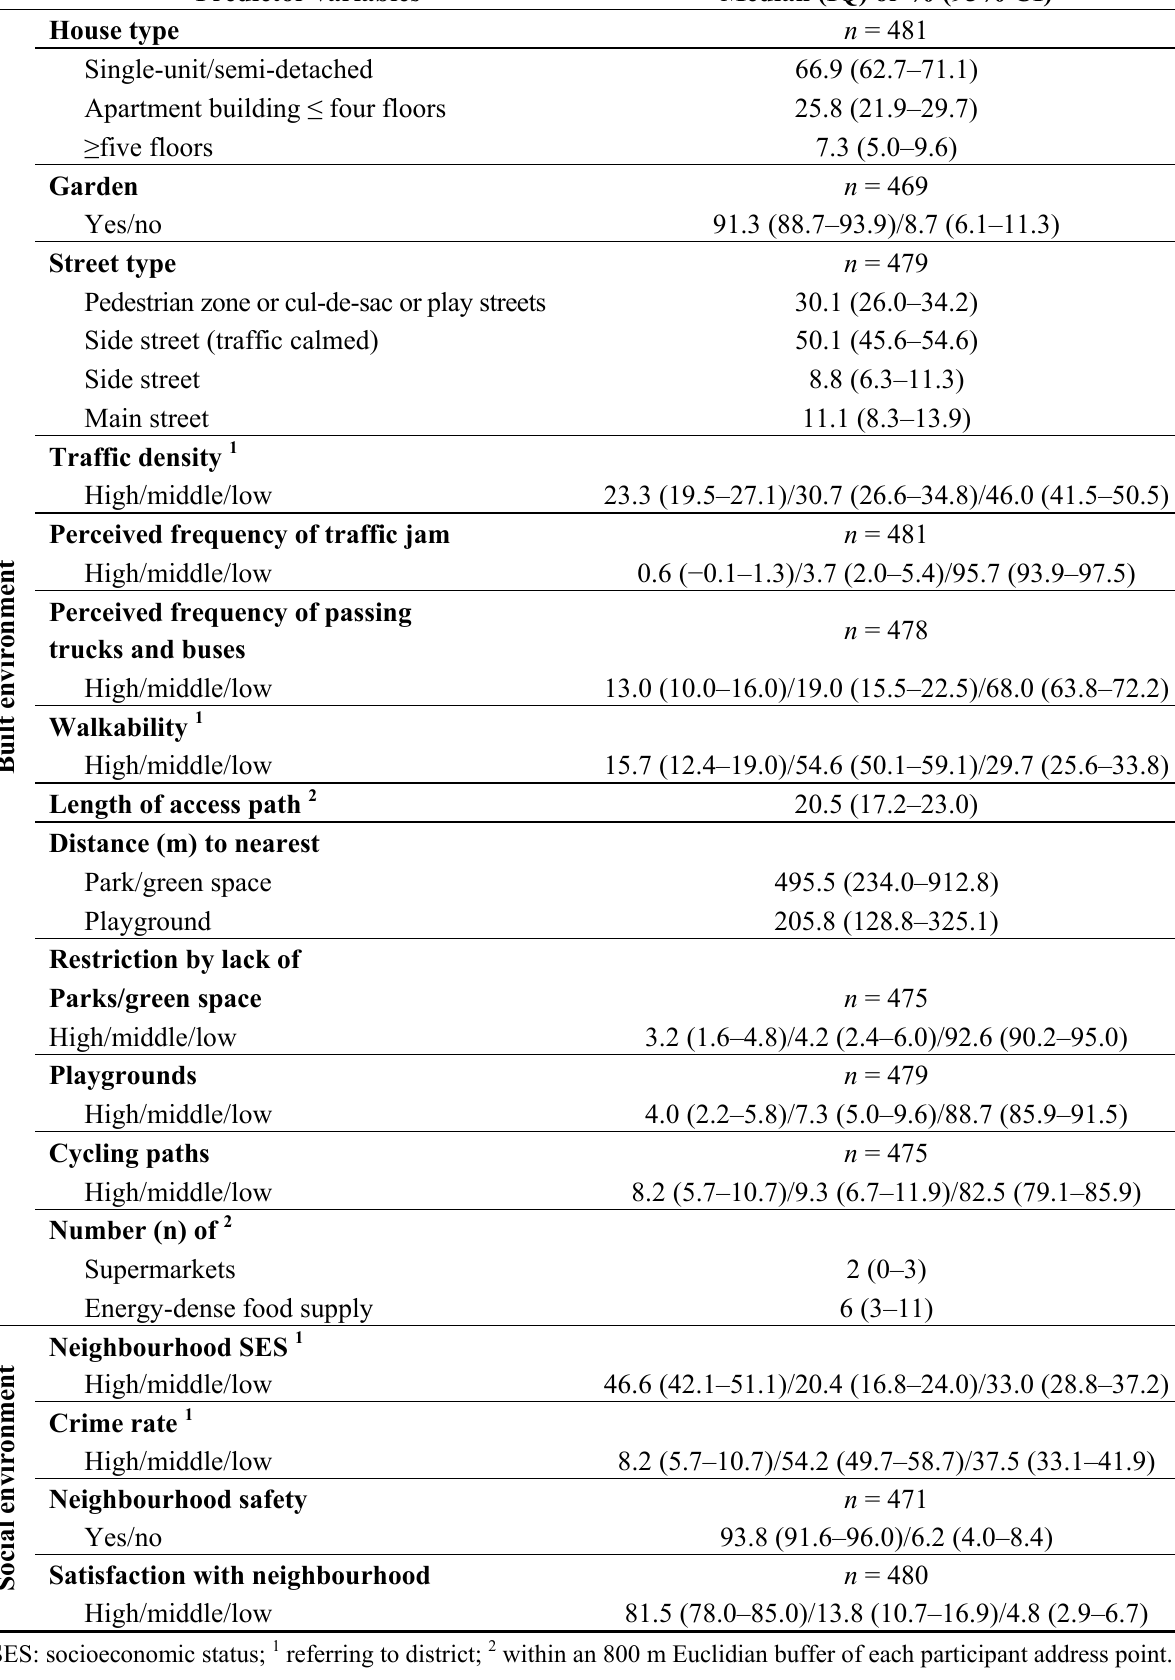
Table 2. Distribution of neighbourhood environment variables among children ( n = 485). Predictor